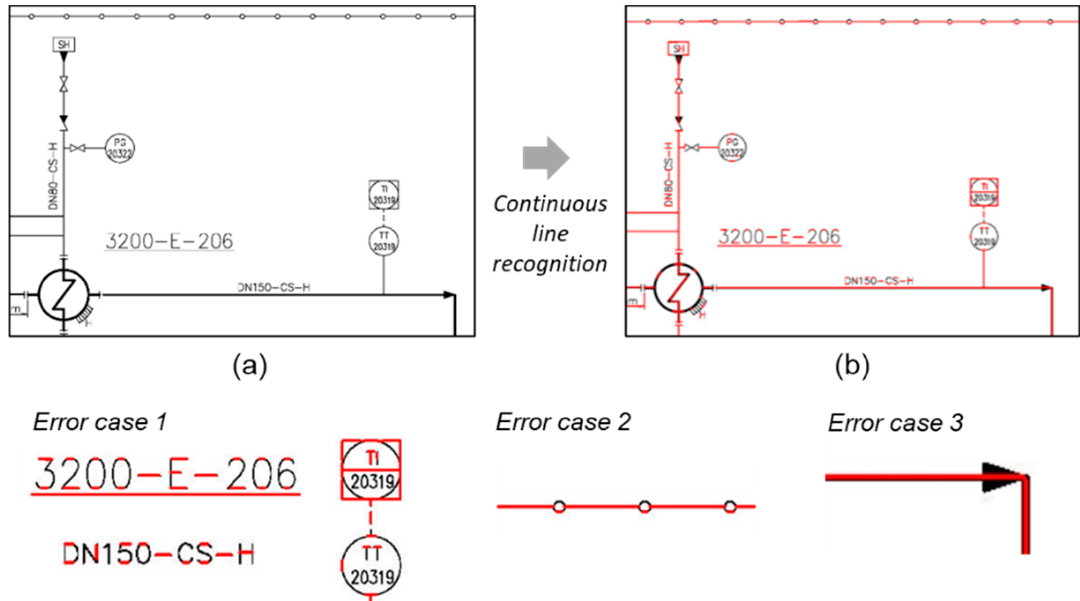
Figure 2. Problems when recognizing line objects using image processing techniques only. ( a ) An image of P&ID. ( b ) Recognized continuous lines.